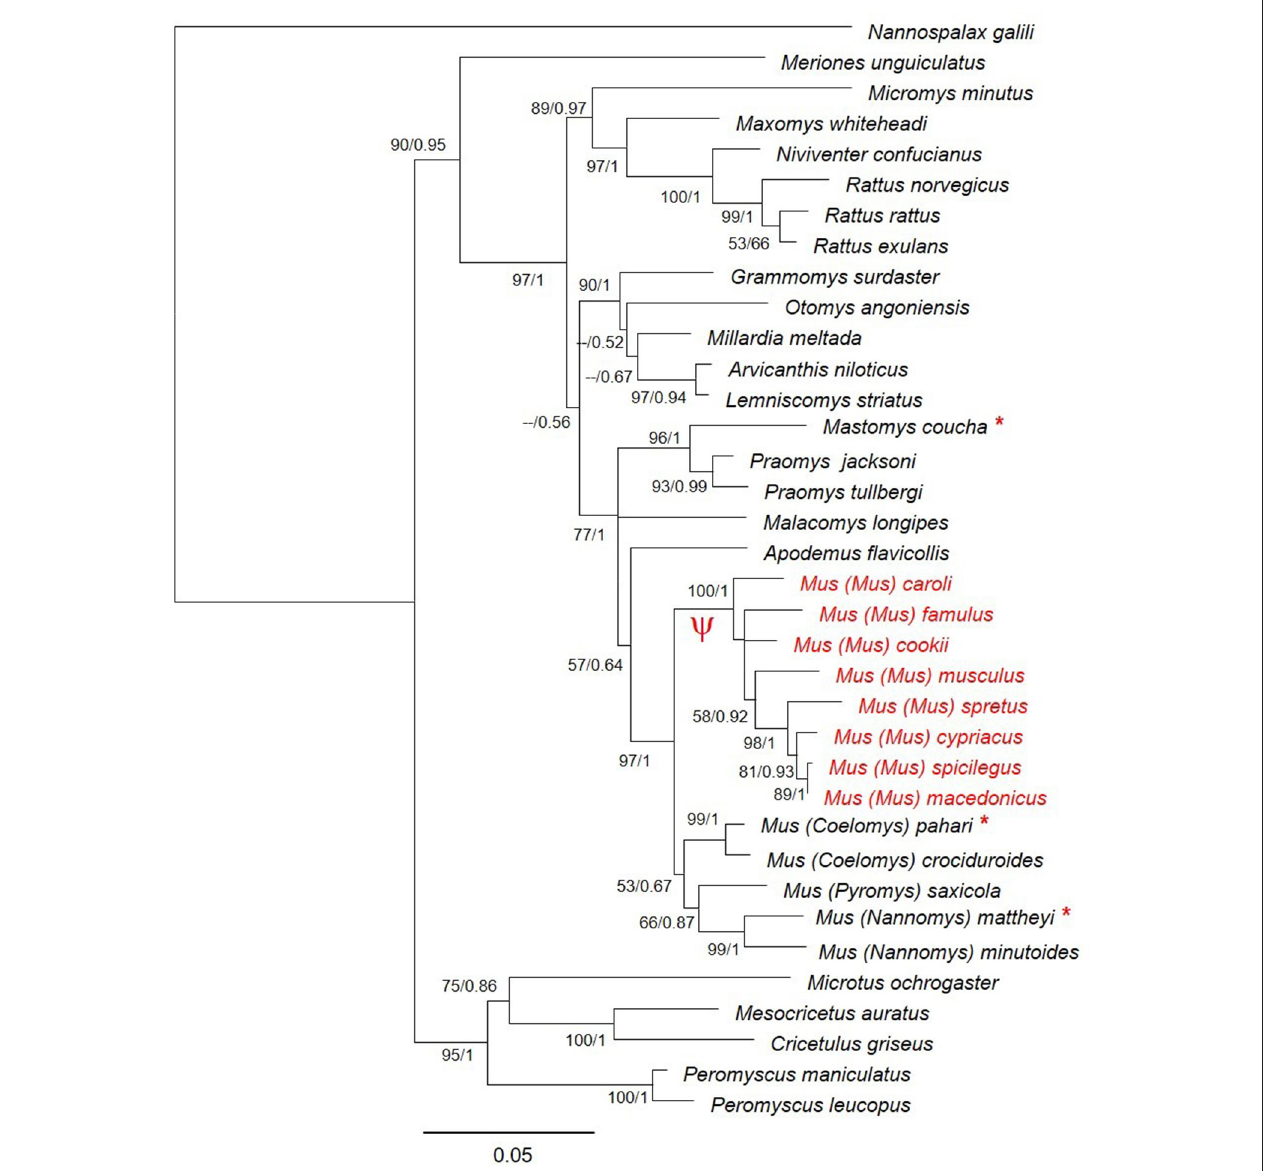
FIGURE 2 | Phylogenetic relationships of Zp4 gene in different species of muroid rodents. Bootstrap support and posterior probabilities are indicated for each node. The species where Zp4 is a pseudogene are indicated in red. The symbol Ψ indicates the branch of the tree where the pseudogenization probably took place. The species for which we sequenced the mRNA are indicated with an